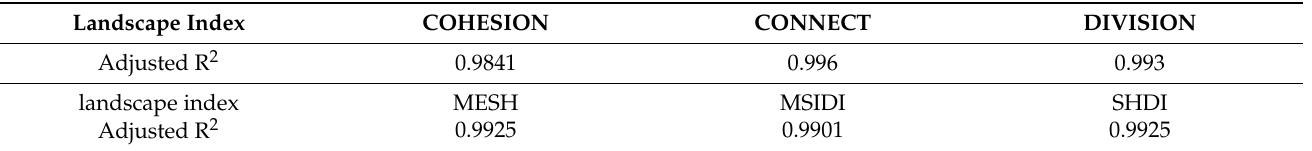
Table 4. Fitting goodness of correlation coefficient exponential landscape